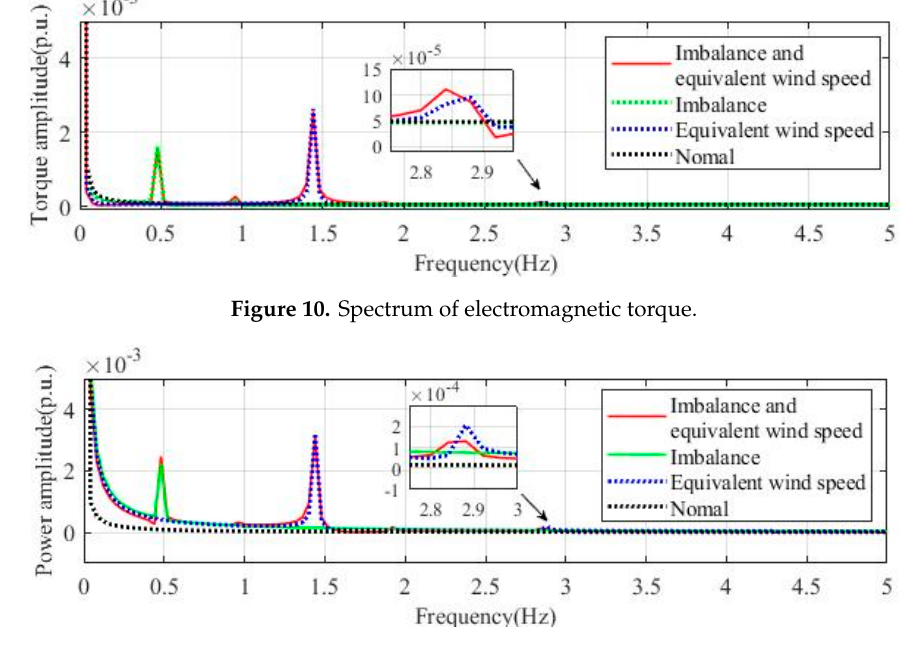
Figure 11. Spectrum of electromagnetic power.